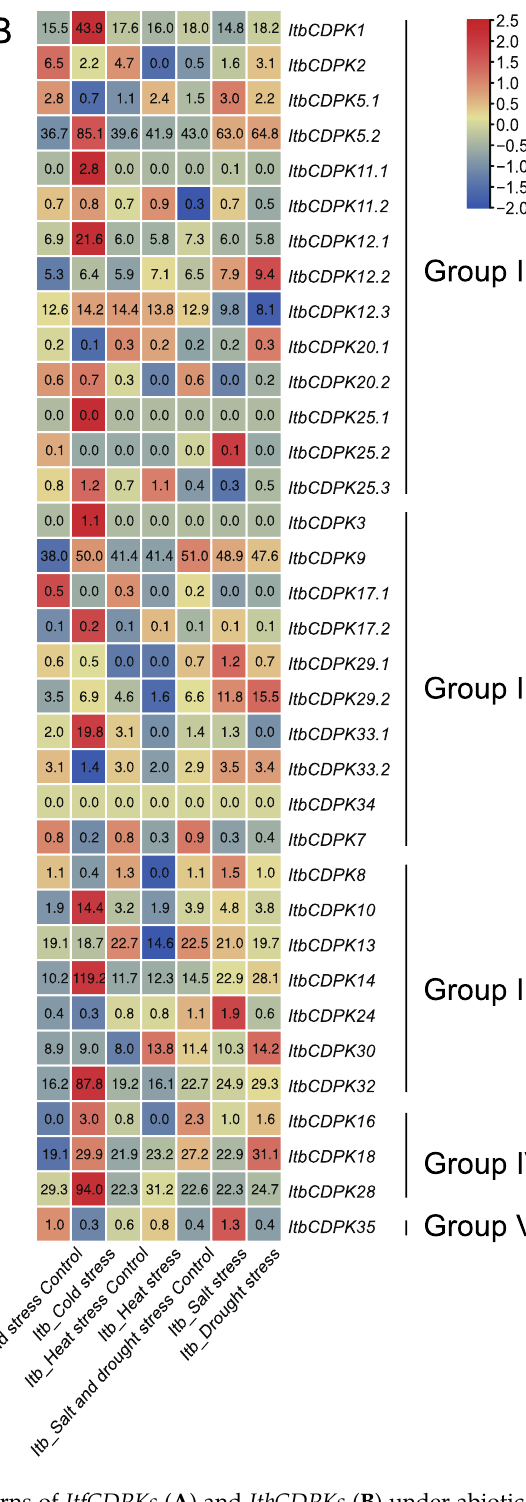
Figure 11. Gene expression patterns of ItfCDPKs ( A ) and ItbCDPKs ( B ) under abiotic stress (cold, heat, salt, and drought) in I. trifida and I. triloba as determined by RNA-seq. Log 2 (FPKM+1) is shown in the boxes.